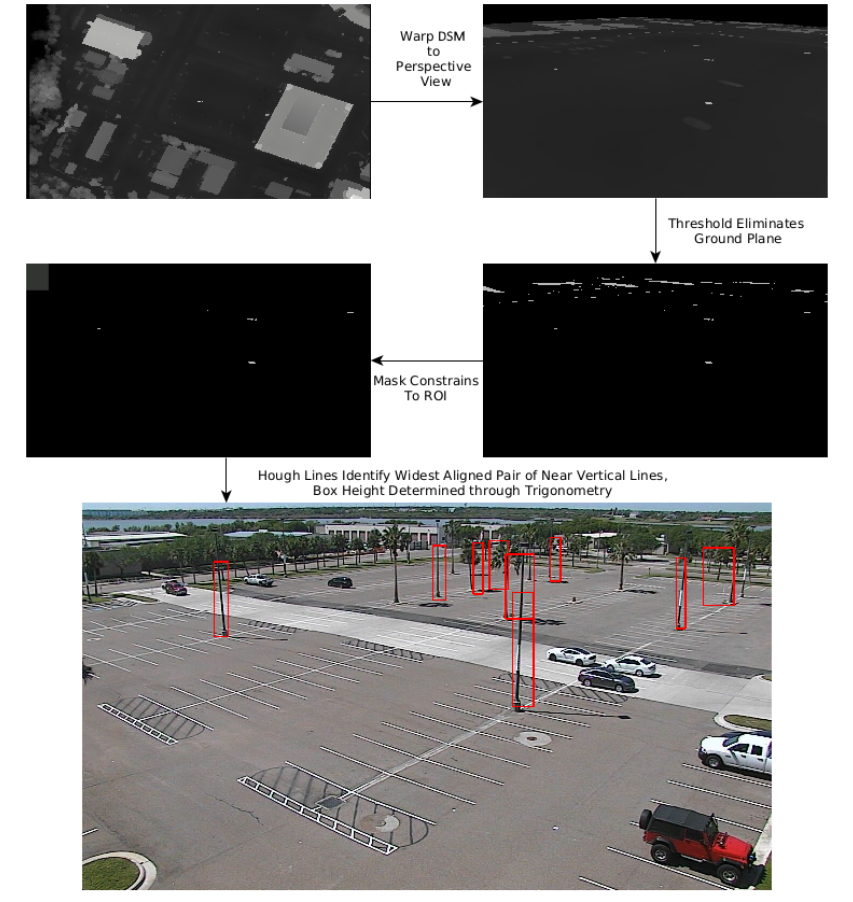
Figure 6. The process and results of using images registered via monoplotting to determine approxi- mate occlusion areas from a Hough transformation cross referenced with the DSM and trigonometry. Note that some occlusion regions encompass vertically oriented features entirely, while some only encompass partial features. Furthermore, the occlusion regions are substantially buffered in this image for the reader. The actual regions are quite closely constrained to the actual vertical lines in each